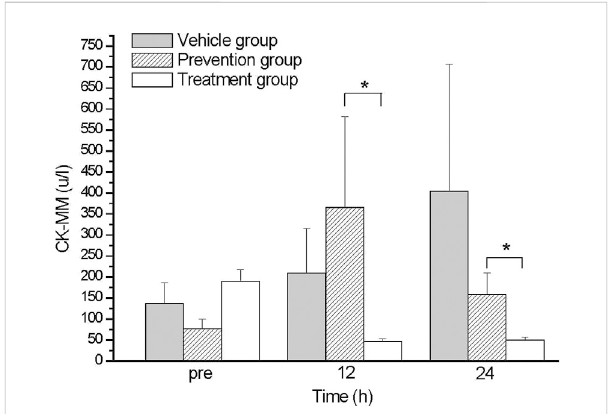
FIGURE 1 The comparison of CK-MM levels between groups. The CK-MM levels of treatment group were lower than those in prevention group at 12 and 24 hs. *indicates p -value < 0.05, compare with prevention